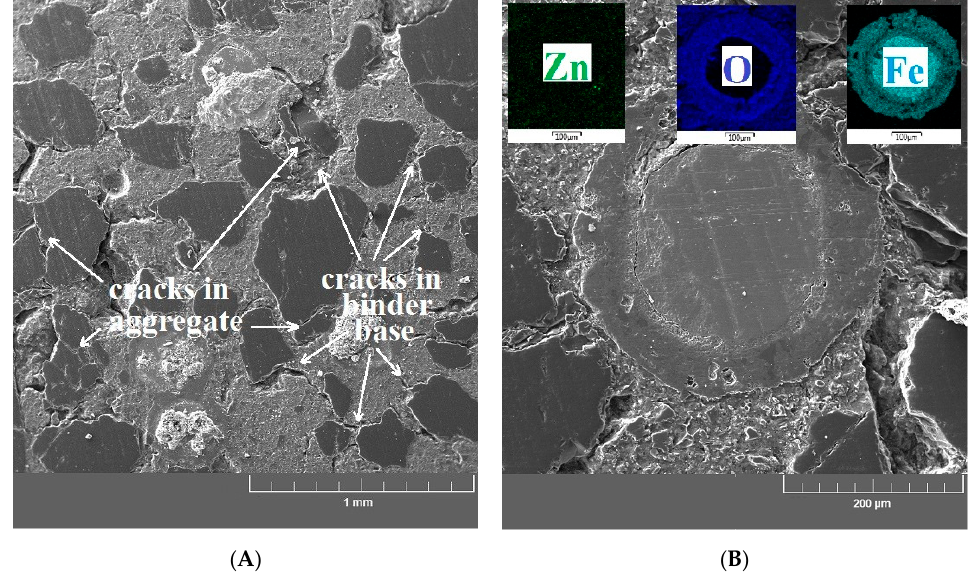
Figure 19. ( A ) SEM image of a sample after exposure to at 800 °C focused on UHPC matrix/aggregate interfacial transition zone. ( B ) SEM image of a sample after exposure to 800 °C focused on the brass-coated steel fiber/UHPC matrix interfacial transition zone.